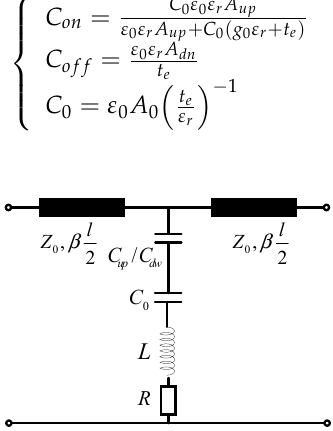
Figure 4. The geometry configuration of the proposed RF MEMS switch.